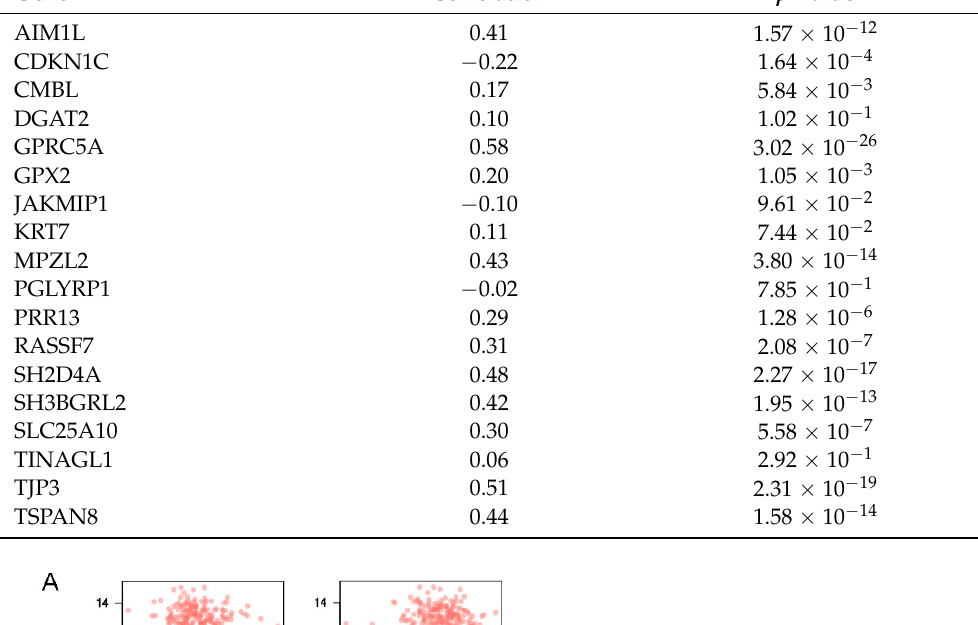
Table 3. Pearson correlation between expression of KLF5 and other genes in TCGA gastric can- cer study. Gene